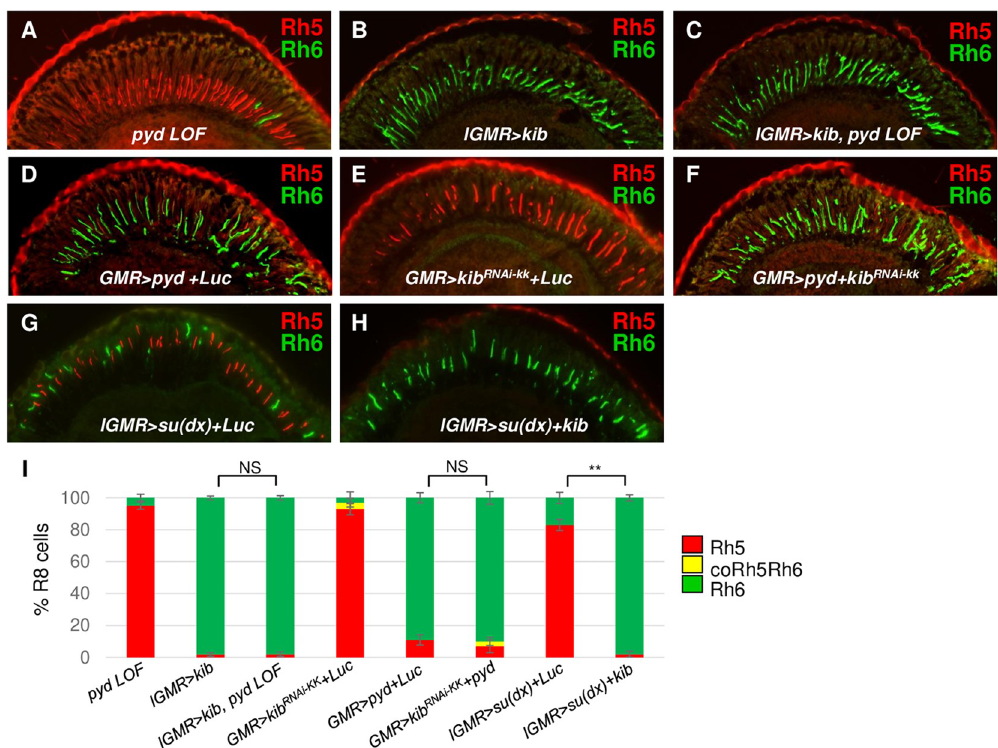
Fig 7. Pyd genetically functions in parallel to kib to specify R8 subtypes. (A-H) Cryosections of adult eyes stained for Rh5 (Red) and Rh6 (Green) in pyd LOF (A, pyd ex180 /pyd B12 ), kib misexpression (B, GMR > kib ), kib misexpression in pyd LOF (C, GMR > kib , pyd ex180 /pyd B12 ), pyd overexpression (D, GMR > pyd+Luc ), kib knock-down (E, GMR > kib RNAi-kk +Luc ), kib knock-down in pyd misexpression (F, GMR > pyd + kib RNAi-kk ), su(dx) GOF (G, lGMR > su(dx)+Luc ) and su(dx) , kib double GOF (H, lGMR > su(dx)+Luc ) flies. UAS-Luciferase ( UAS-Luc ) was used as a control to balance the number of UAS sites. (I) Quantification of Rh5 and Rh6-expressing R8s in the eyes with the indicated genotypes. NS: not significant. �� P < 0.001. Error bars represent standard deviation. pyd LOF: n = 10 retinas, n = 1902 R8s; lGMR > kib : n = 6 retinas, n = 1020 R8s; lGMR > kib , pyd LOF: n = 6 retinas, n = 1002 R8s; GMR > kib RNAi-KK +Luc : n = 4 retinas, n = 934 R8s; GMR > pyd + Luc RNAi : n = 6 retinas, n = 912 R8s; GMR > pyd+kib RNAi-KK : n = 4 retinas, n = 1002 R8s; lGMR > su(dx) + Luc :n = 4 retinas, n = 830 R8s; lGMR > su(dx)+kib : n = 4 retinas, n = 1052